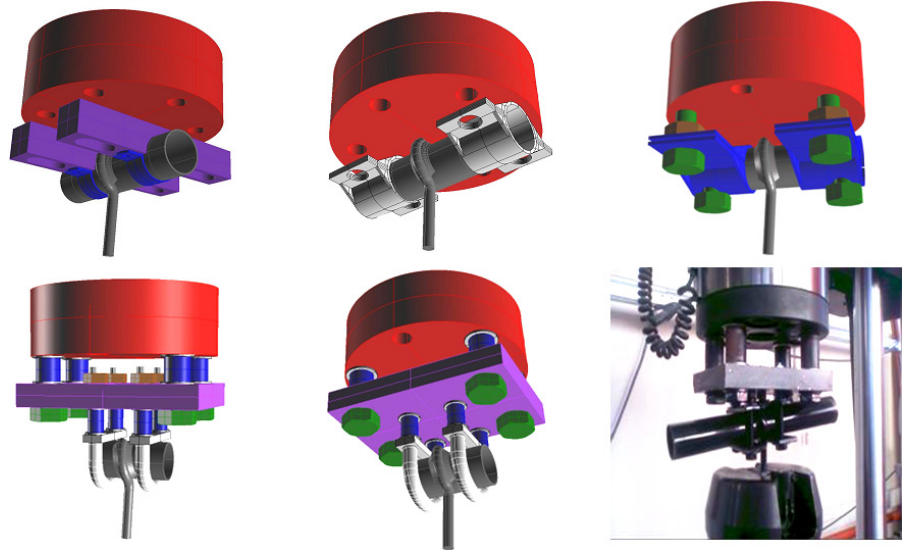
Figura 3: Studio preliminare sistemi di ancoraggio (in alto); ancoraggio adottato (in basso).